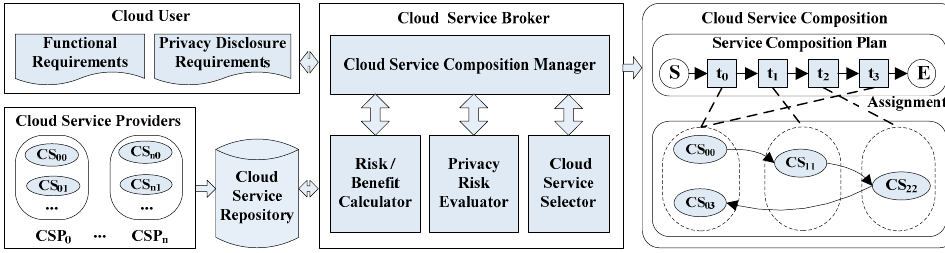
Figure 1. The CS selection architecture that balances privacy risk and benefit for an